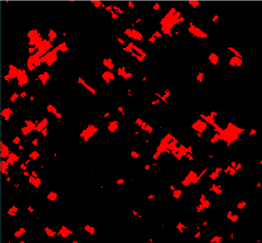
Figure 10 Extracted building footprints from RBFE